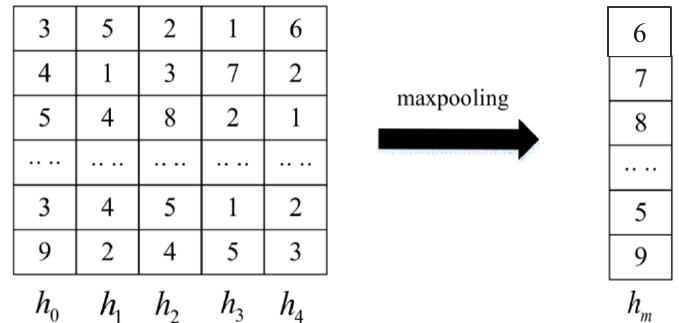
Figure 5. Maxpooling